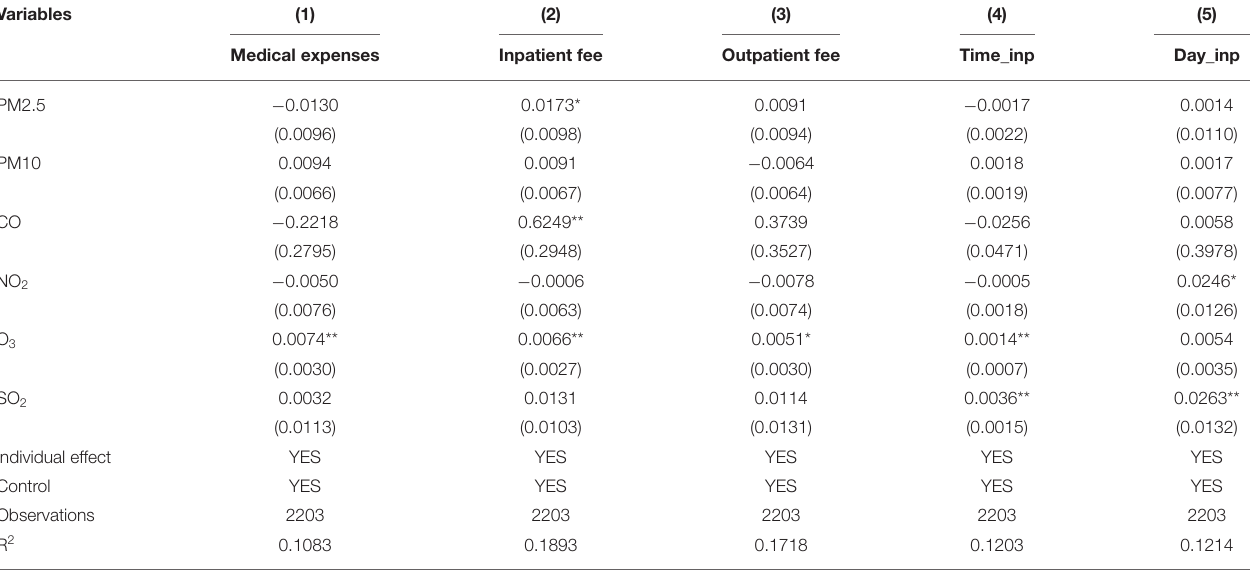
TABLE 9 | Heterogeneity of different pollutants: air pollution and medical expenses.